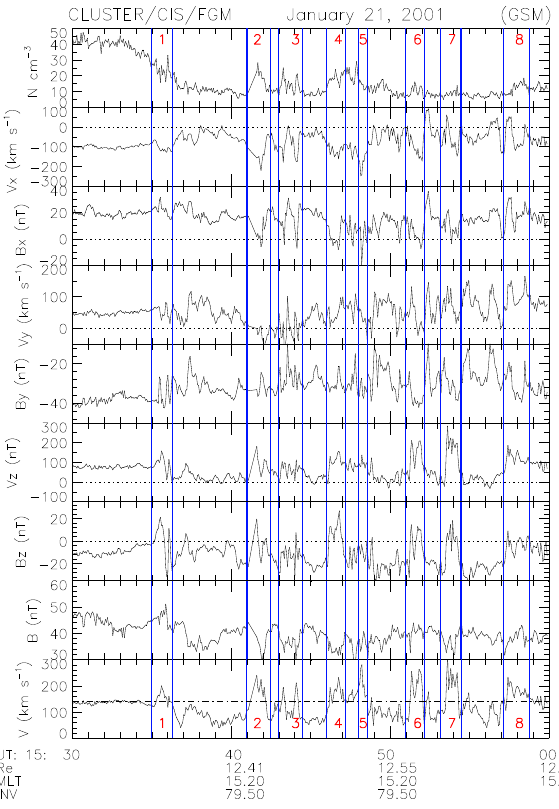
Fig. 6. An expanded view of the Cluster 1 observations during 15:30–16:00 UT. From top to bottom are displayed the plasma density, pairwise flow and field components, total field and total flow strengths. We marked and numbered all flow bursts exceeding 140km/s (see bottom panel). The legend gives the radial distance, MLT and invariant latitude of the